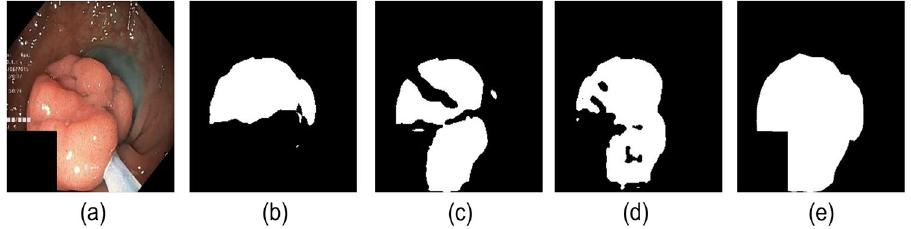
Figure 6. Some pseudo-labels of polyp segmentation obtained by baseline supervised model, Baseline + CL and the baseline + CL + CUPL (Proposed) on the testing subset. Note that the labeled/unlabeled images used for the training was 50/750. Further, ( a–e ) denotes original image, output of “Baseline”, “Baseline + CL”, “Baseline + CL + CUPL (Proposed) ”, and ground truth respectively.